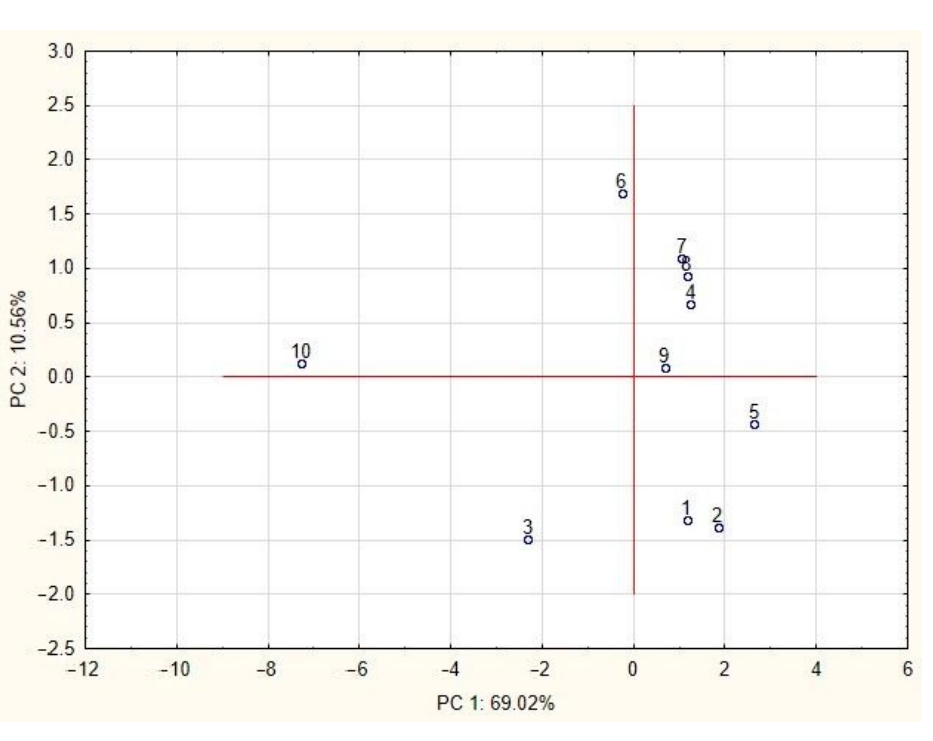
Figure 5. PCA score plot of tested goldenrod honey samples (1–10).